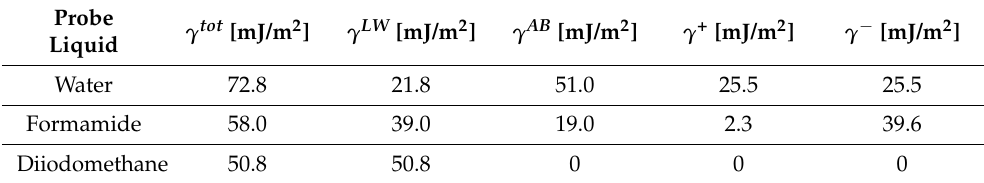
Table 1. Values of surface tension and its components of the used testing